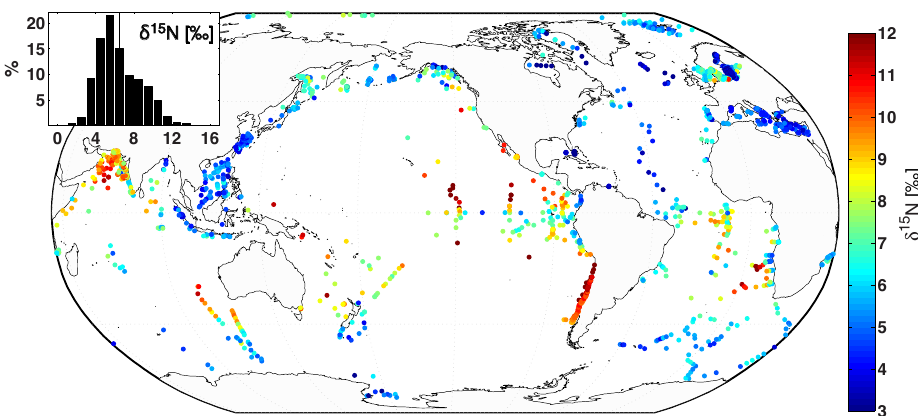
Fig. 1. Spatial distribution of surface sediment δ 15 N samples. References for published data are provided on the web site. Unpublished data are from Galbraith et al. (2013) and this study. Inset: histogram of surface δ 15 N (in 1-kyr bins). The vertical line indicates the mean of 6.7‰, higher than the average δ 15 N of nitrate in the ocean ( ∼ 5‰). Note the dataset is skewed towards heavier nitrogen isotopic